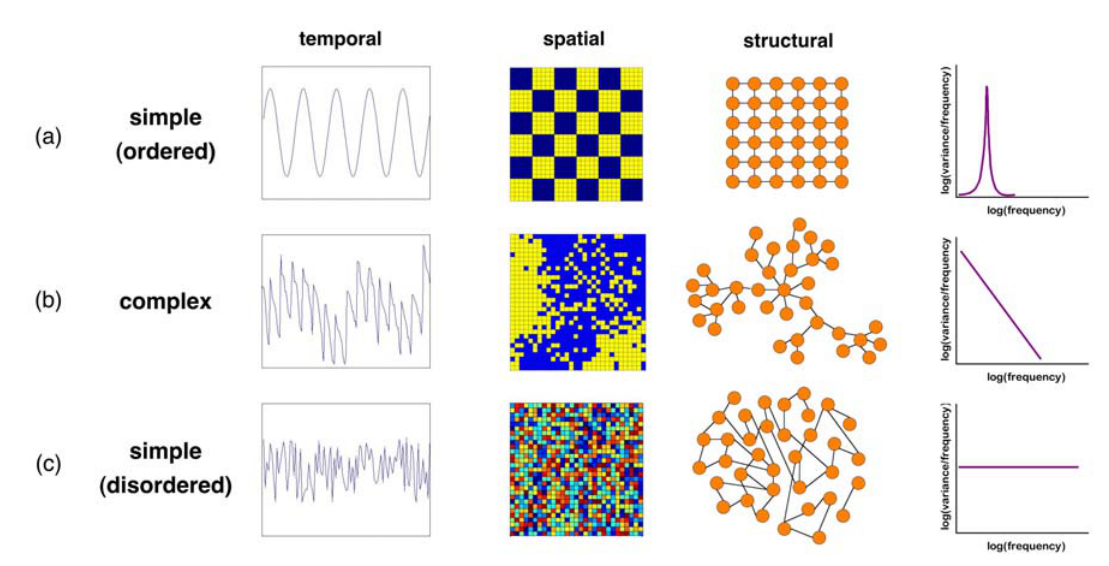
Figure 1. Temporal, spatial and structural signatures of simple ordered and disordered systems versus a complex system. (a) Sinusoidal time series; ordered spatial pattern; regular network; (b) Population dynamics of a modelled plant species from the individual-based model WIST [38]; spatial distribution of prey in the Lotka-Volterra model with diffusion over a coupled map lattice (generated with the model in [39]); scale-free network typical of some food webs; (c) Uniformly distributed random noise; random spatial distribution; random network. For each case, the rightmost column shows a schema of a corresponding frequency analysis, one of the most common descriptive measures of complexity that can be applied to temporal, spatial or structural signatures. For each case (a, b, c), the analysis is shown for the distribution of frequencies in the temporal signature, although it might also be applied to measure the distribution of patch sizes in the spatial signature, or the distribution of links per node in the